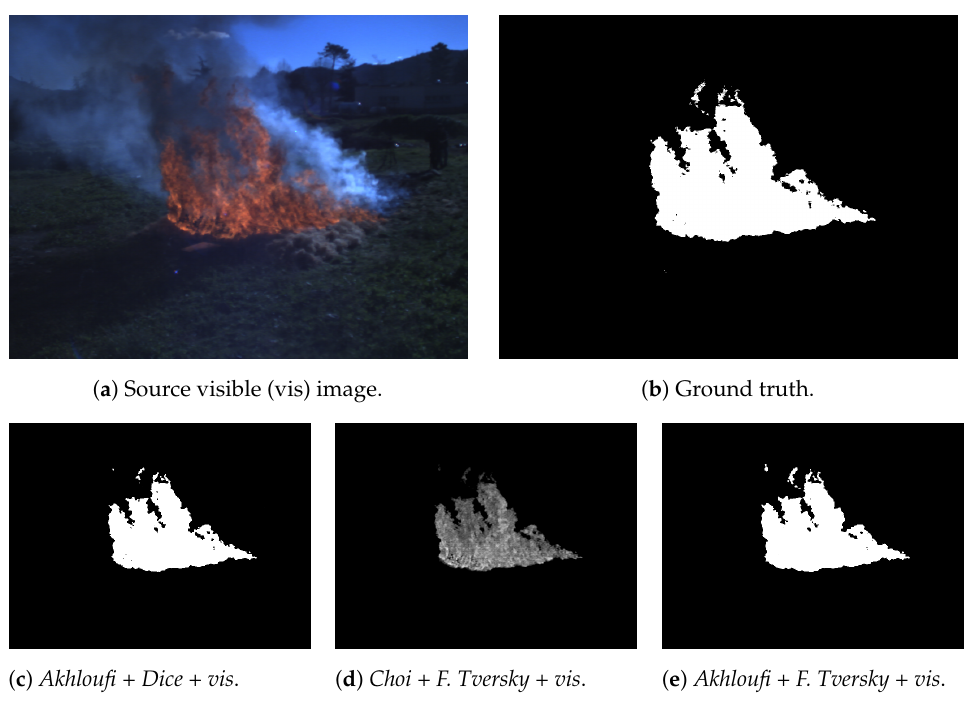
Figure 15. Sample segmentation results for the top three combinations for all metrics. For the segmentation results of the Choi architecture, we binarized the images by assigning a value of 1 to all non-zero pixels in a post-processing